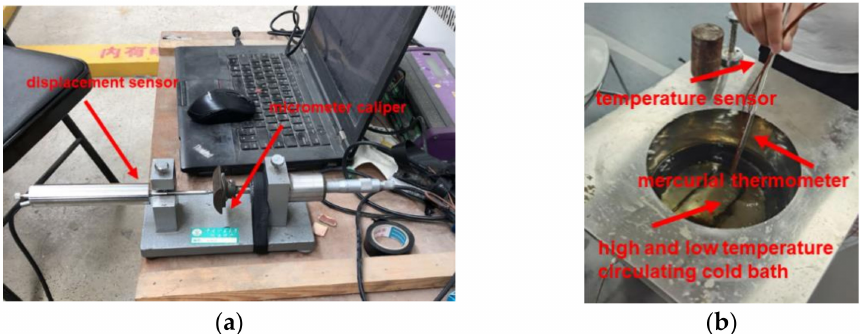
Figure 5. Sensor calibration: ( a ) Calibration of displacement sensor with screw micrometer ( b ) Tem- perature sensor calibration.